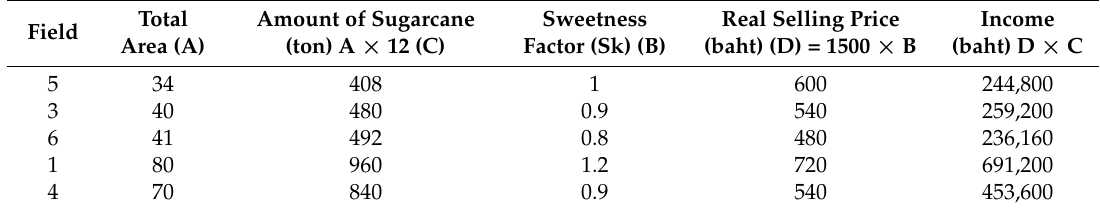
Table 5. Income of the harvesting